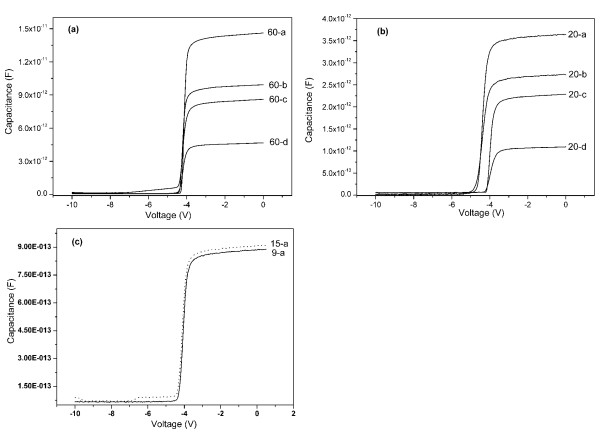
MeasuredC-Vcurves at room temperature of the Ni Schottky contacts. With different areas for the devices with drain-to-source distances of 60 (a), 20 (b), and 15 and 9 μm (c).